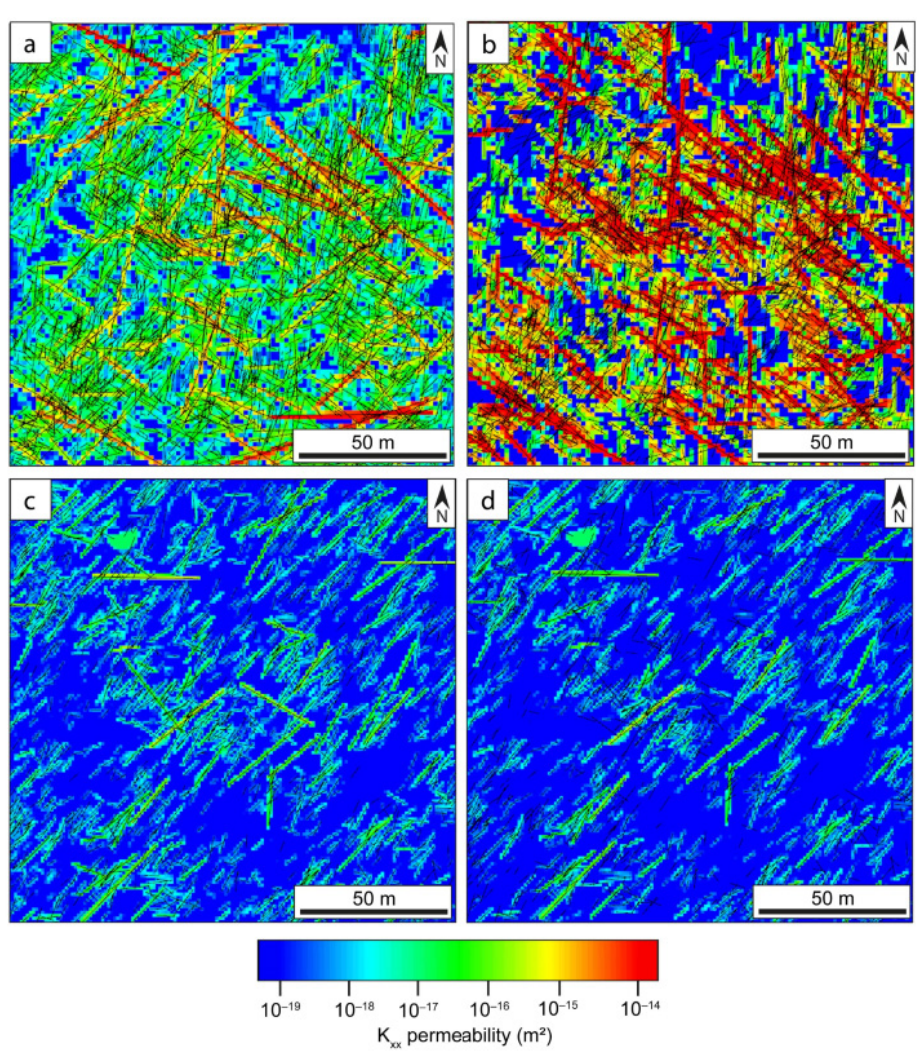
Figure 8. Equivalent permeability grid for ( a ) DFN case 1, 10% of open fractures, andfracture length dependant aperture and ( b ) DFN case 1, 10% of open fractures, and shear dependent aperture, and ( c ) DFN case 2, 10% of open fractures, andfracture length dependant aperture and ( d ) DFN case 2, 10% of open fractures, and shear dependent aperture